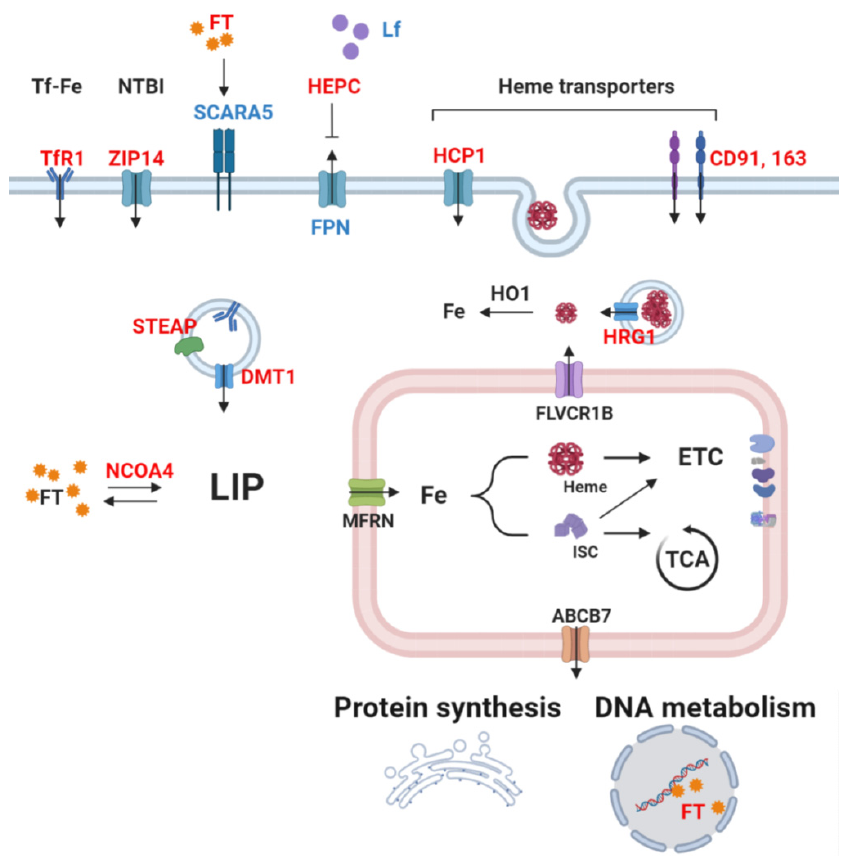
Figure 1. Simplified scheme of cellular iron metabolism in cancer cells. Red: upregulation reported in cancer. Blue: downregulation reported in cancer. Cancer cells commonly show increased uptake of iron by transferrin receptor 1 (TfR1). After binding of transferrin-bound iron (Tf-Fe or TBI) on its receptor, the complex is carried to the intracellular space by endocytosis. Coordination of six-transmembrane epithelial antigen of prostate (STEAP) and divalent metal transporter (DMT1) releases free iron in the cytosol. Circulating free, non-transferrin-bound iron (NTBI) can also be imported by ZIP14. Hepcidin (HEPC) secretion by the liver downregulates ferroportin (FPN) levels, consequently causing iron accumulation in the intracellular space. Cancer cells also deploy other iron-acquisition methods, e.g., via heme importers, including HCP1, CD91, and CD193. Heme-responsive gene 1 (HRG1) allows the cytosolic release of heme imported by endocytosis. Moreover, increased ferritinophagy, and hence the degradation of ferritin–iron (FT) complexes by NCOA4, further increases bioavailable iron. Altogether, these mechanisms lead to elevated labile iron pool (LIP). After incorporation in enzymes’ prosthetic moieties or alone as a cofactor by the mitochondria, iron can fuel the TCA cycle and the electron transport chain or be exported to the cytosol and participate in translational process as well as DNA replication or repair.